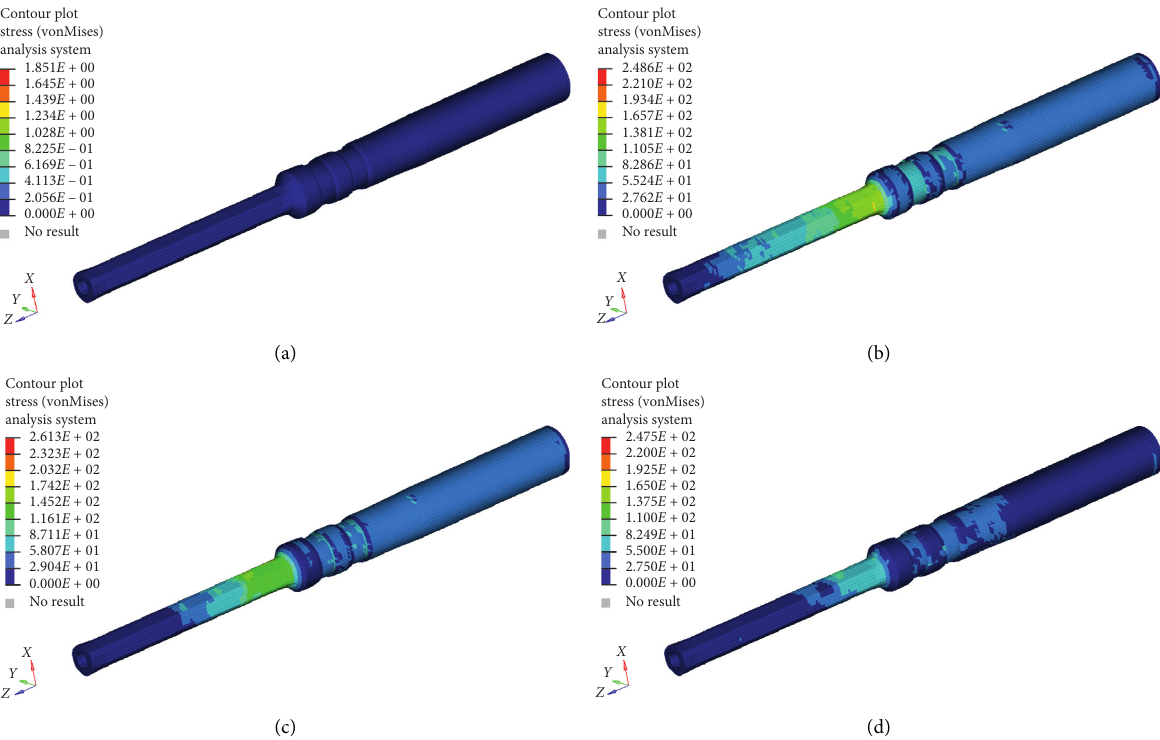
Figure 18: Stress nephograms of the steel anchor under different tensile loadings: (a) 25% RTS; (b) 50% RTS; (c) 95% RTS; (d) ultimate load.